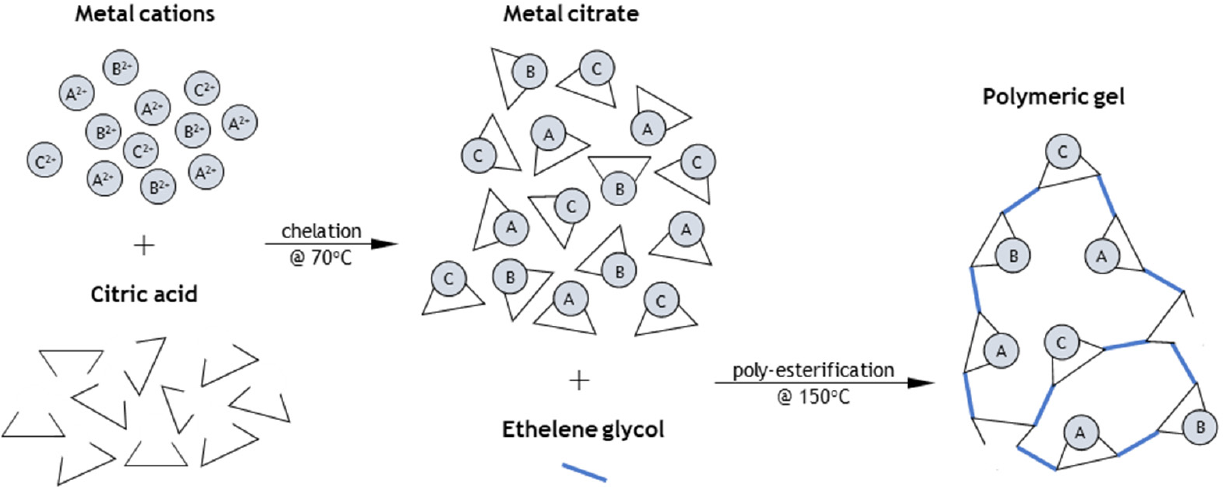
Figure 2. Schematic of the polymeric metal/organic gel precursor produced through the Pechini sol–gel method.